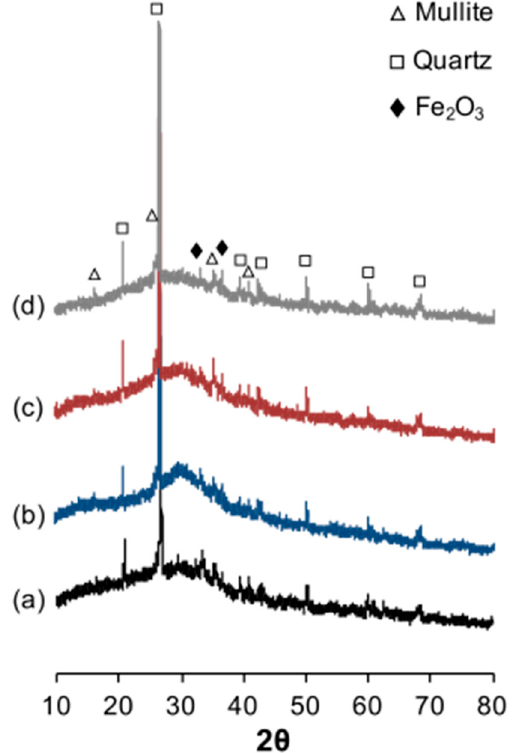
Figure 2. Representative X-Ray Diffraction (XRD) traces of Huntly fly ash (Huntly-FA) and Huntly FA-based geopolymer catalyst (Huntly-GP). ( a ) as-received Huntly-FA; ( b ) FA-based geopolymer “as-synthesised”; ( c ) NH 4 + -form of the geopolymer; ( d ) NH 4 + -geopolymer after heating to 550 °C.